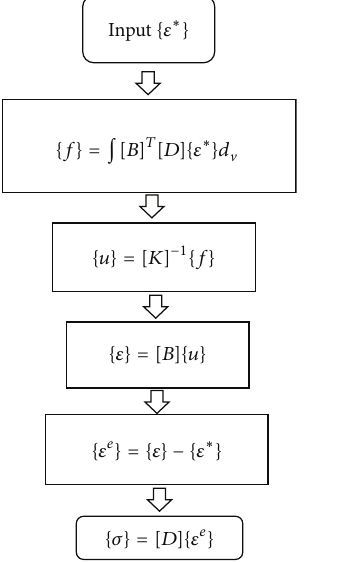
Figure 5: Analysis procedure of inherent strain method.